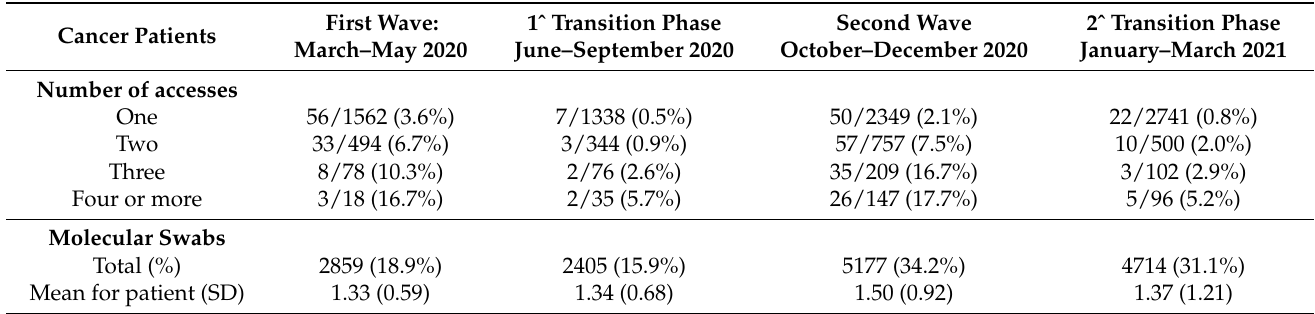
Table 3. SARS-CoV-2 incidence rate for Cancer Patients (CPs; N = 8733) from the first to second wave of the